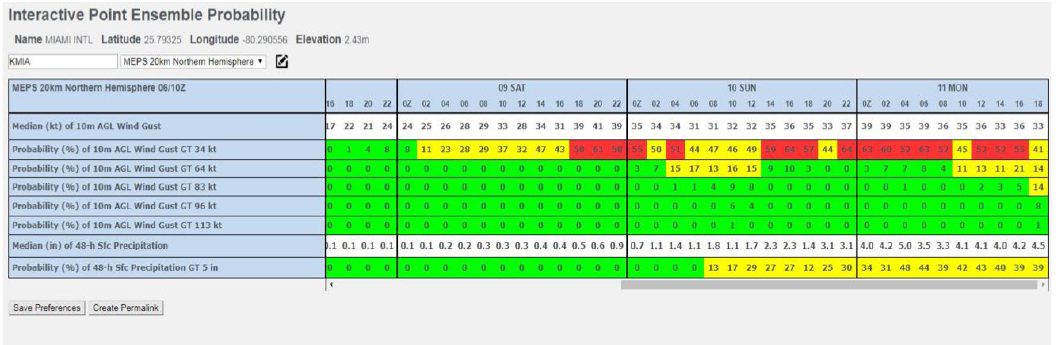
Figure 13. Interface for the iPEP capability, with tailored probability (percent) thresholds in the left column, and resultant probabilities in the rows on the right, for the approach of Hurricane Irma in Miami, FL in 2017.